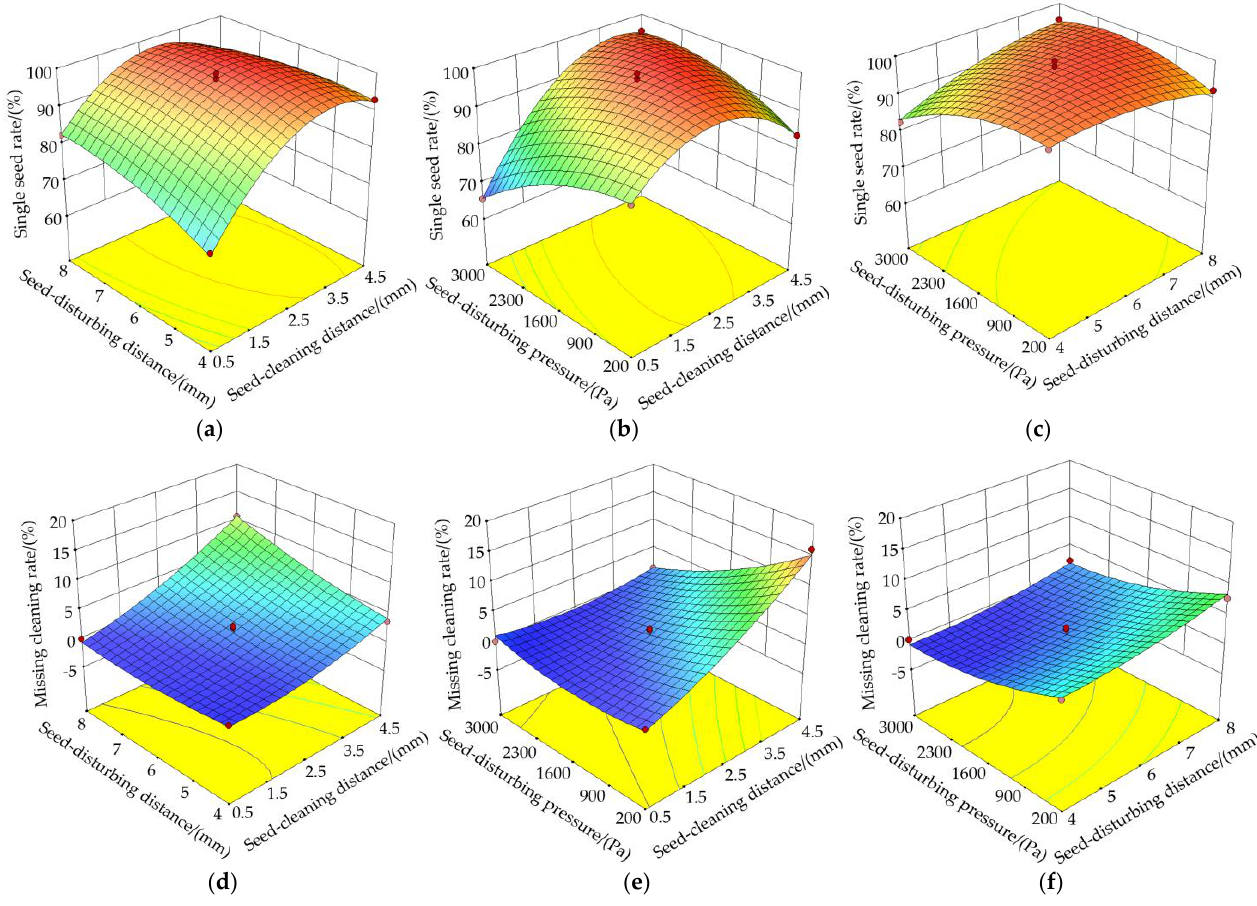
Figure 12. Response surface of interaction factors effects on single seed rate and missing cleaning rate: ( a ) S 0 ( X 1 , X 2 , 0), ( b ) S 0 ( X 1 , 0, X 3 ), ( c ) S 0 (0, X 2 , X 3 ), ( d ) M 0 ( X 1 , X 2 , 0), ( e ) M 0 ( X 1 , 0, X 3 ), and ( f ) M 0 (0, X 2 , X 3 ).